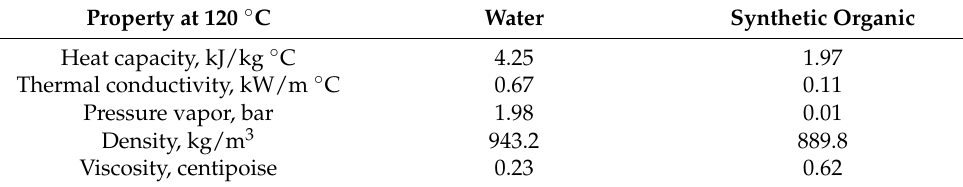
Table 4. Thermal properties of water and synthetic